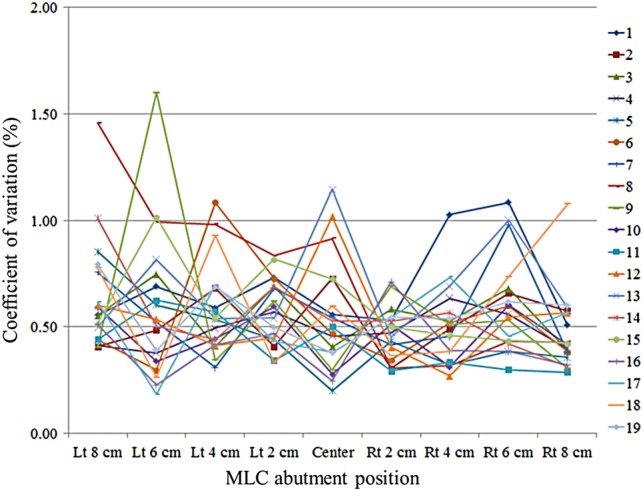
Coefficients of variation measured 10 times at each MLC abutment position for 19 leaves. The x-axis shows the MLC abutment positions ranging from 8 cm to the left to 8 cm to the right at 2-cm intervals, and the y-axis shows the coefficients of variation at the MLC abutment positions measured 10 times. Individual leaf numbers are represented by different colored lines.